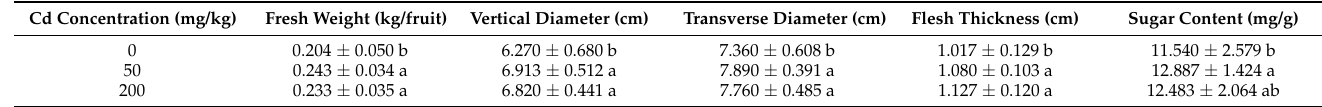
Table 1. Muskmelon fruit size and quality analysis under different treatments. Each treatment was repeated three times, expressed as mean ± standard deviation. Each column with different letters represents significant differences at p < 0.05.